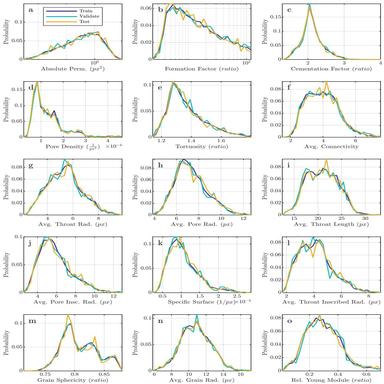
Relative frequency distribution of 15 single–value features for each bundle of the training, validation and testing data.